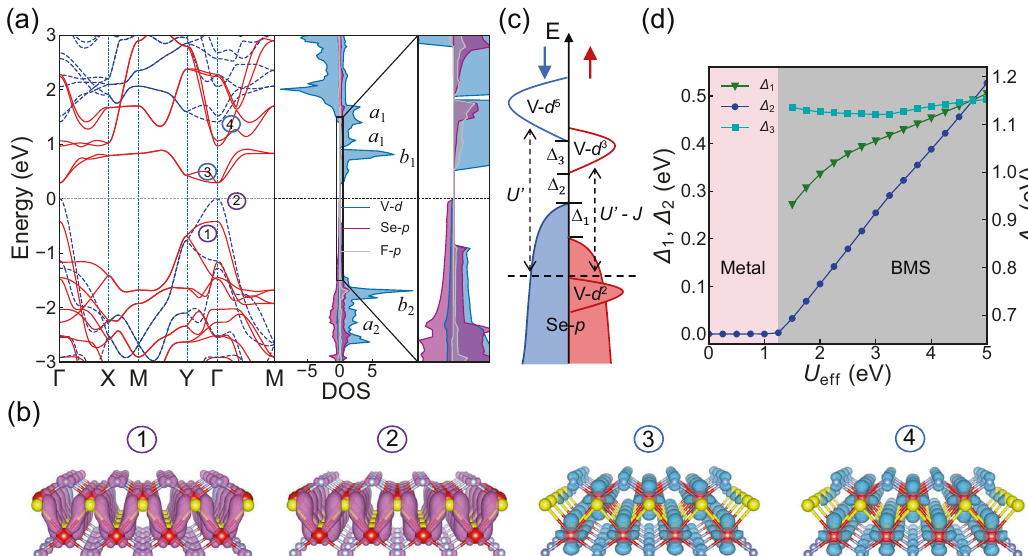
Fig. 2 Electronic structures and the origin of BMS. a Spin-resolved band structure where red lines and blue dashed lines represent spin-up and spin-down channels, respectively, element-resolved PDOS of VSeF monolayer and zoom-in PDOS near the Fermi level where blue, magenta, and gray regions represent the PDOS contributed by V, Se, and F atoms, respectively. Fermi level is set to 0 eV, as labeled by horizontal black dashed line. b Partial charge densities of VBMs and CBMs of both spin channels. The marked numbers correspond to band decomposed locations in panel a. The magenta and blue isosurfaces represent the electron densities of VBMs and CBMs, respectively, where the isosurface value is 4 × 10 – 3 e·bohr -3 . c Schematic spin-resolved DOS of VSeF monolayer with the BMS behavior where the red and blue colors represent spin-up and spin-down channel, respectively, and the BMS feature can be described by three energy parameters ( Δ 1 , Δ 2 , and Δ Δ 3 ). 2 is the bipolar bandgap. d The variations of three energy parameters ( 1.25 eV, VSeF is a metal ( Δ 2 = 0; the pink region). Once U eff is larger than 1.25 eV, VSeF is a BMS (the gray